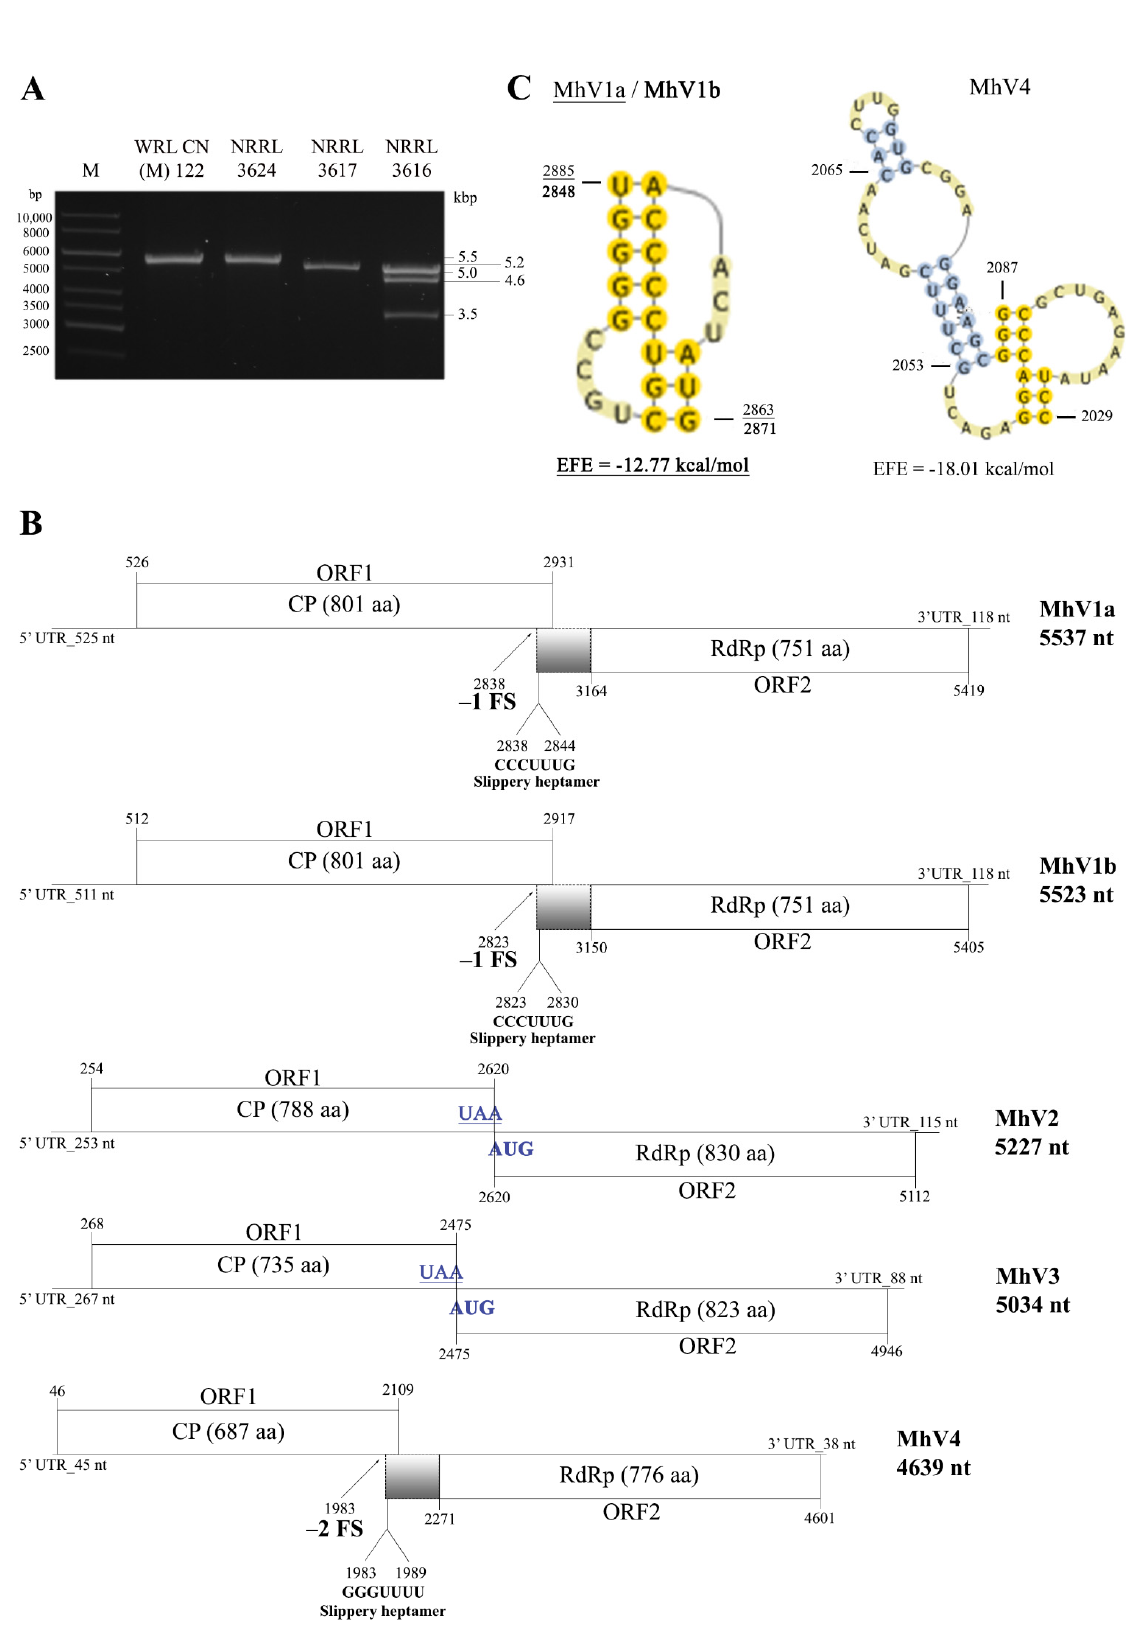
Figure 2. Gel electrophoresis pattern and genomic organization of the detected dsRNA genomes in four mycovirus- harboring Mucor strains. The complete gel can be found in the Supplementary material (Supplementary Figure S1) ( A ) Agarose gel electrophoresis of dsRNA fragments purified from the mycovirus-harboring Mucor strains. Lane M, GeneRuler 1 kb DNA Ladder (Thermo Scientific); Lane 1, Mucor hiemalis f. hiemalis WRL CN(M) 122; Lane 2, Mucor hiemalis f.